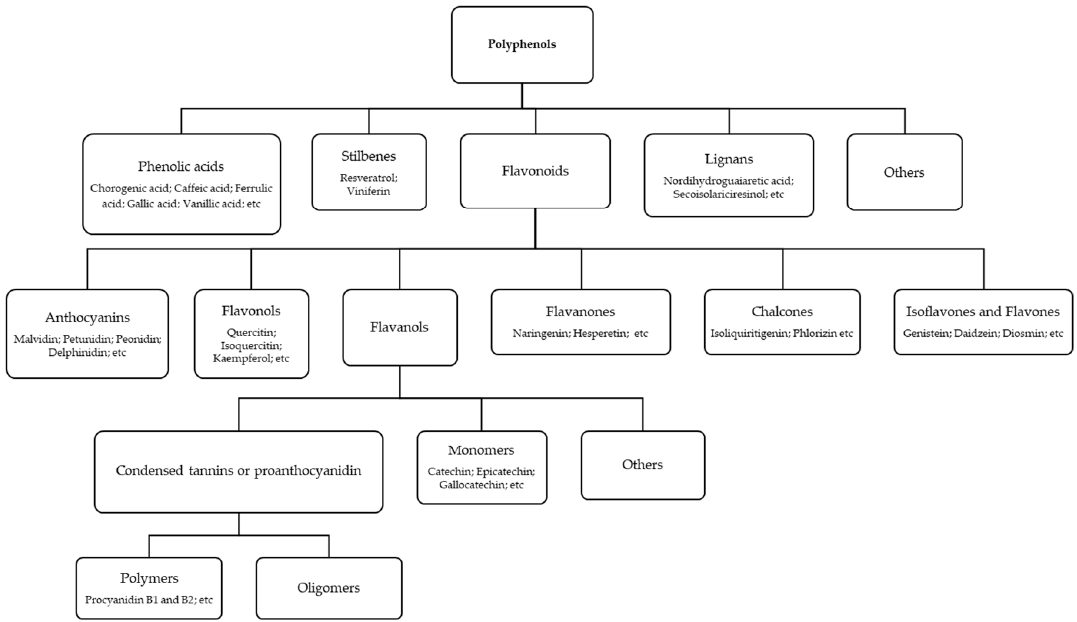
Figure 1. Polyphenols classification based on the number of phenol rings and their structural elements.